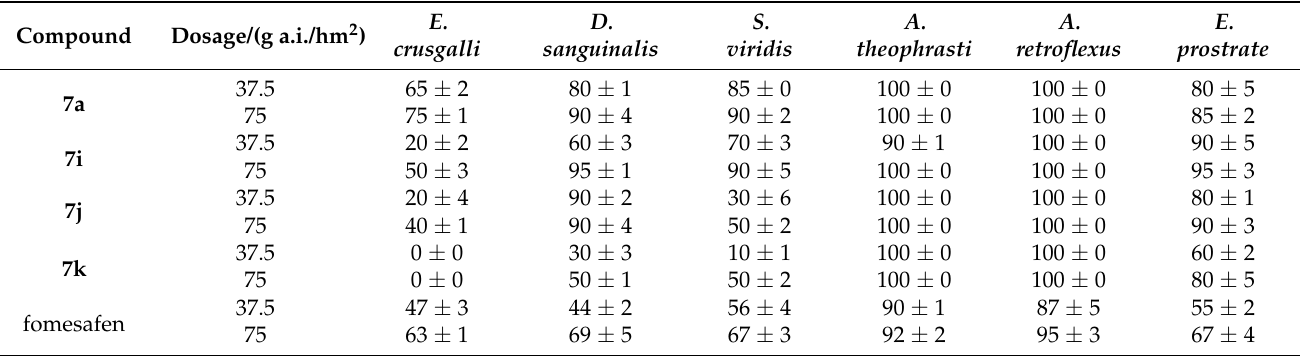
Table 2. Analysis of the herbicidal activities of the selected compounds when used for post-emergence treatment in a greenhouse setting.